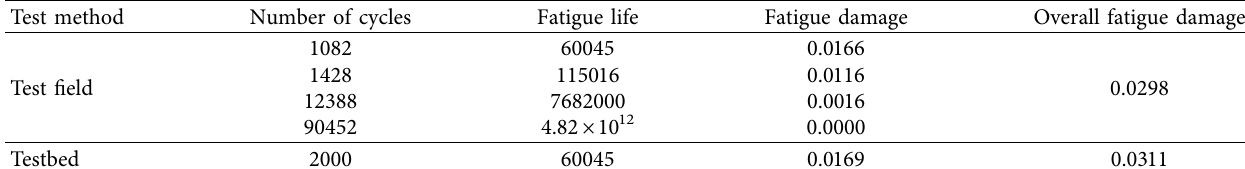
Table 2: Comparison of fatigue damage data under constant amplitude